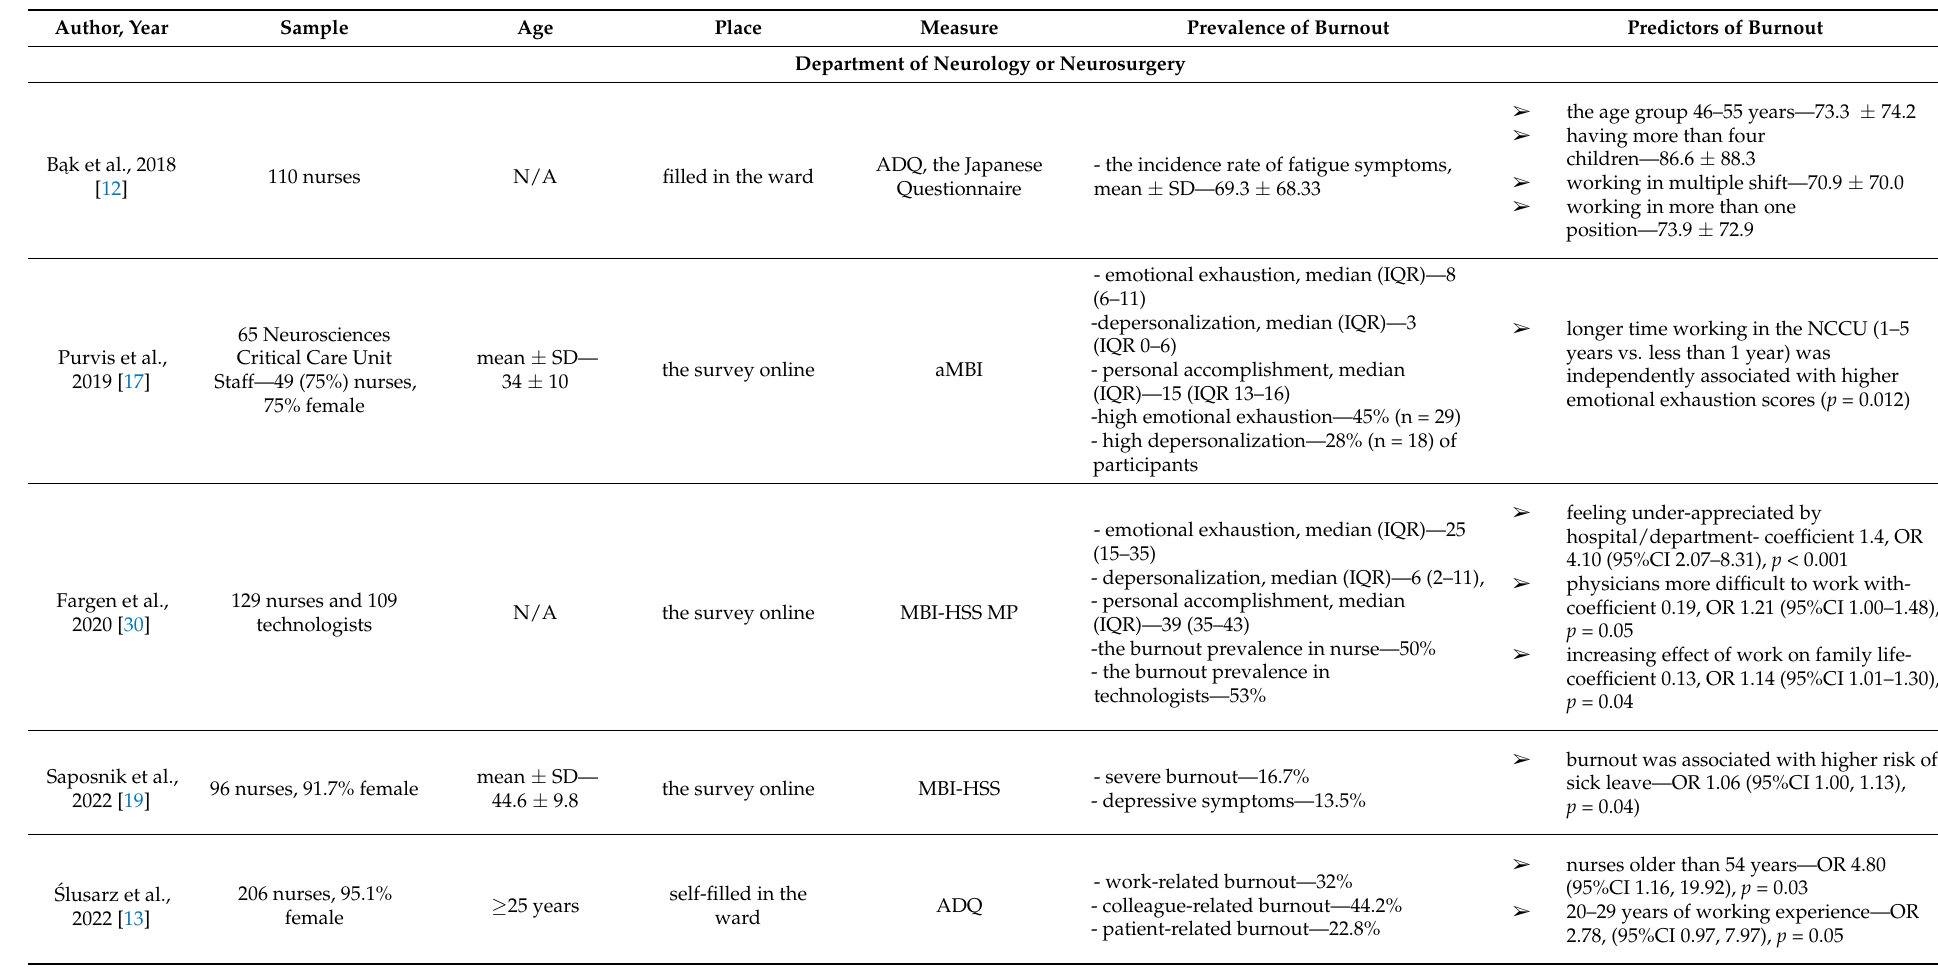
Table 1. Prevalence and characteristic of burnout in